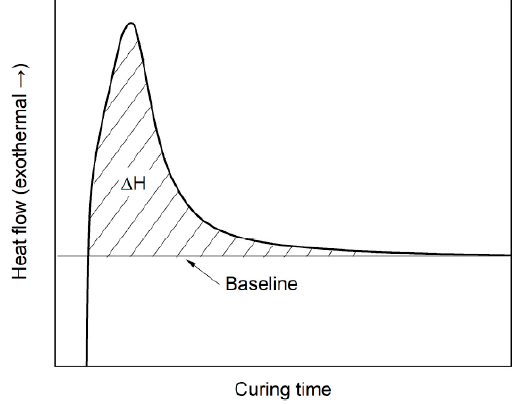
Figure 3. Enthalpy calculation schematic diagram [22].